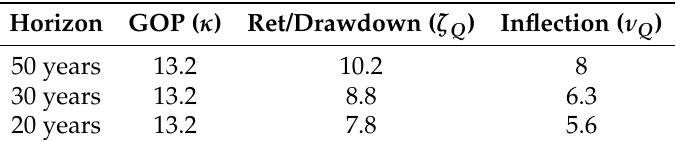
Table 1. Leverage level for 30-year loans.